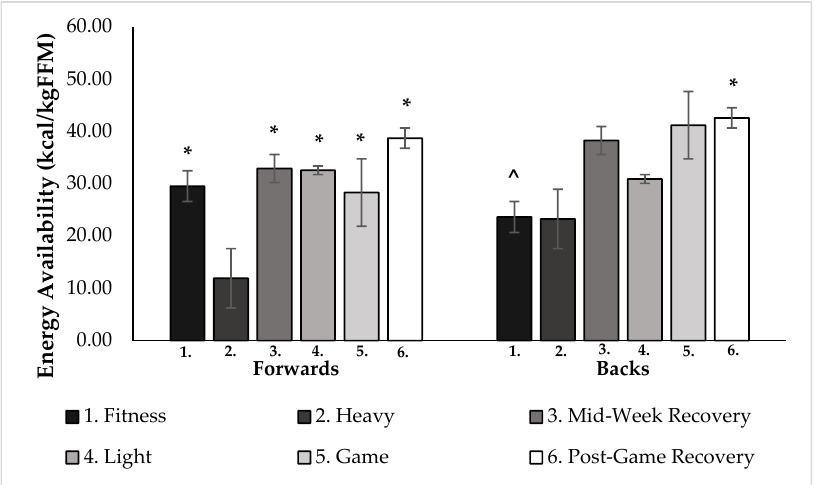
Figure 2. Average daily EA values for 6 different day loads for forward and back positions ( n = 15, 9 forwards, 6 backs). * Significantly different from heavy day ( p < 0.05). ^ Significantly different from post-game recovery day ( p < 0.05).